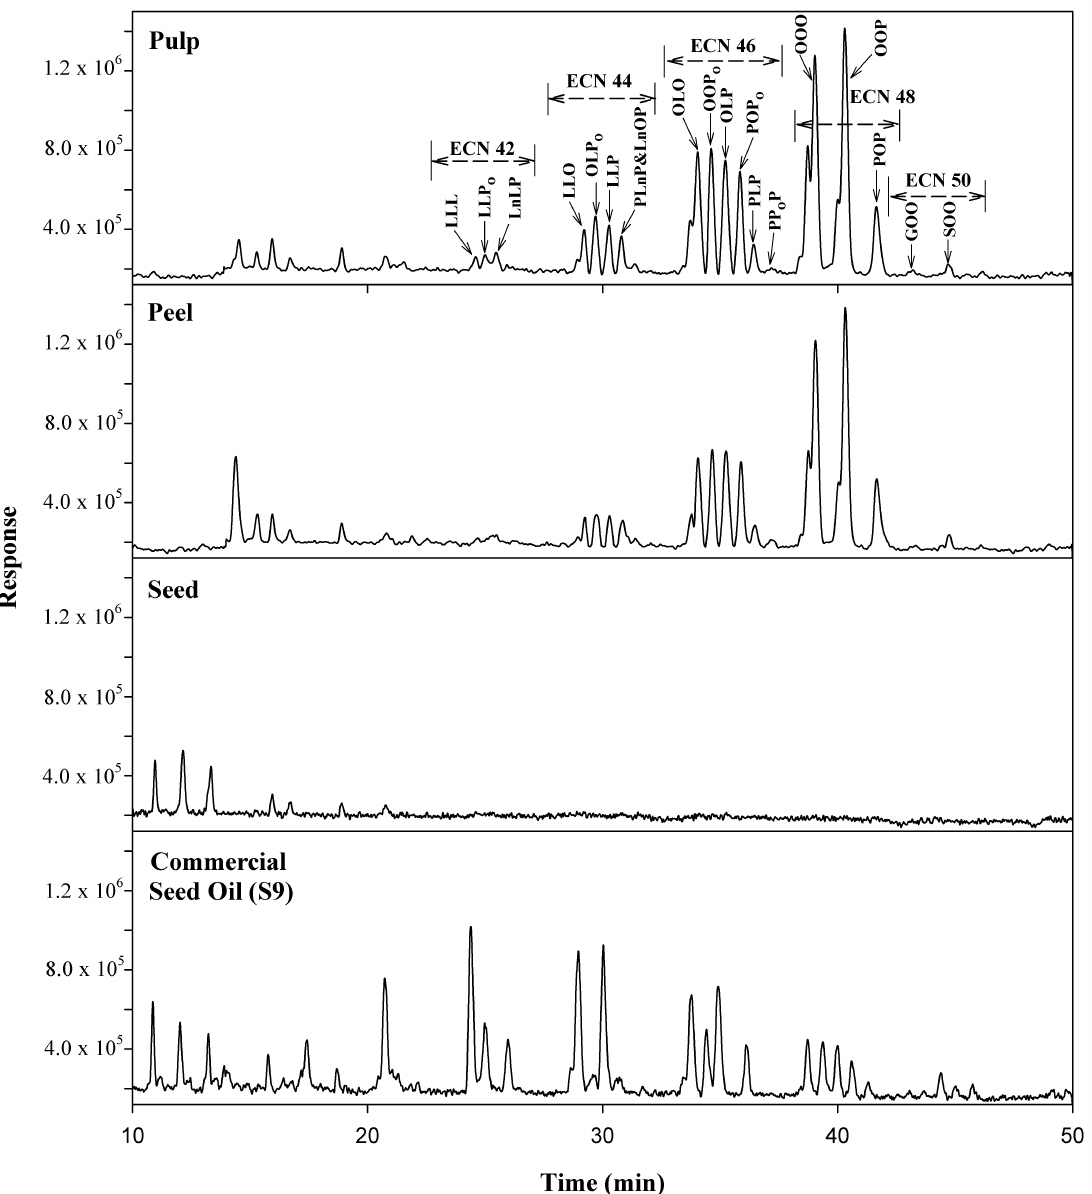
Figure 2. Total ion chromatograms of authenticated avocado oils extracted from pulp, peel, seed and commercial avocado seed oil. ECNs: the equivalent carbon